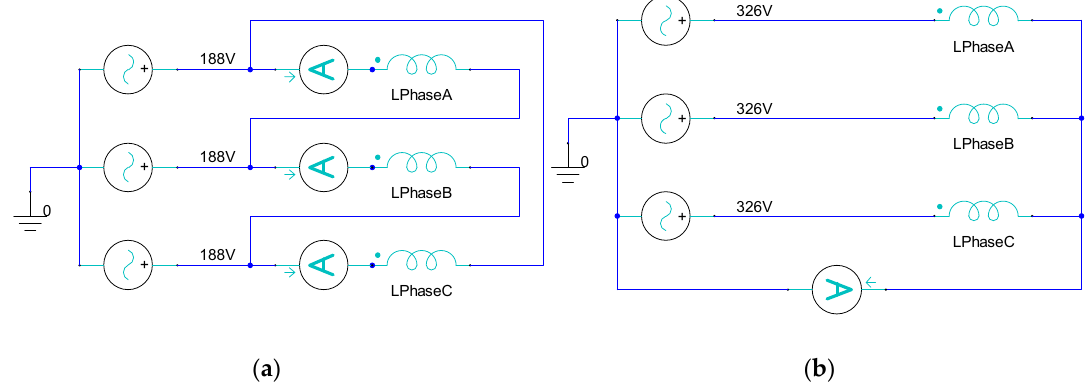
Figure 7. The stator winding connections of the motor for finite element simulation using Maxwell Circuit Editor: ( a ) delta connection; ( b ) wye connection with the neutral wire.